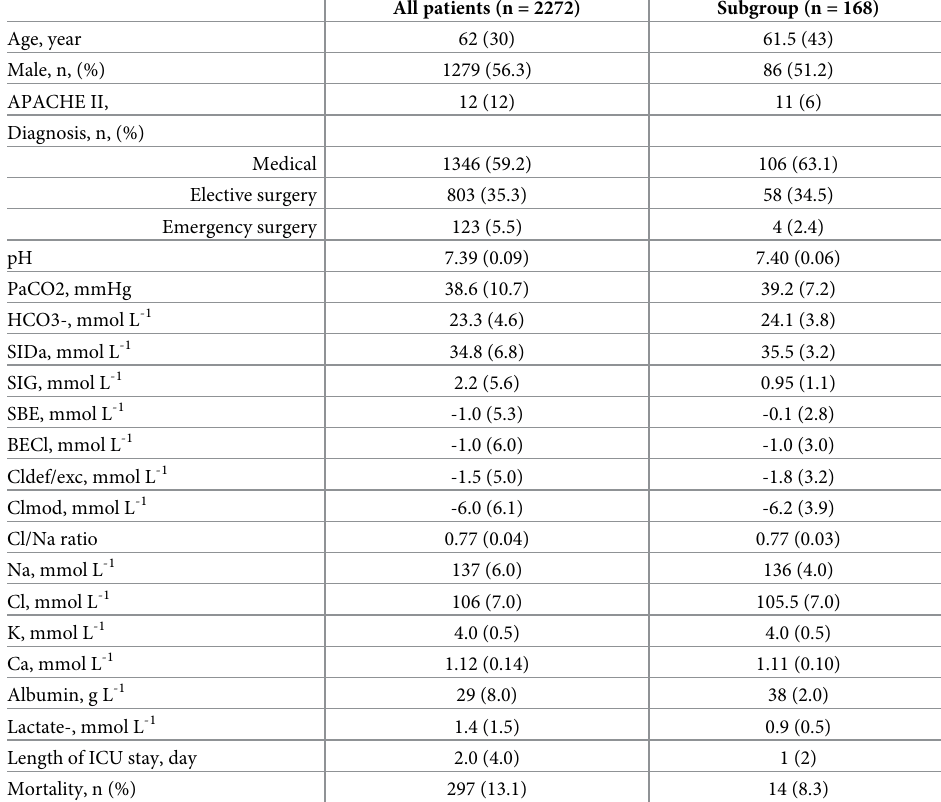
Table 2. Characteristics and outcomes for all patients and subgroup.